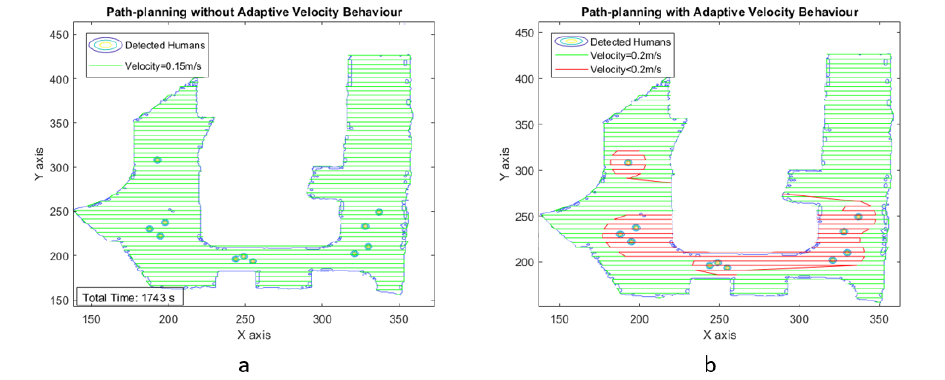
Figure 16. Zig-zag-based area coverage path generated for scenario IV.